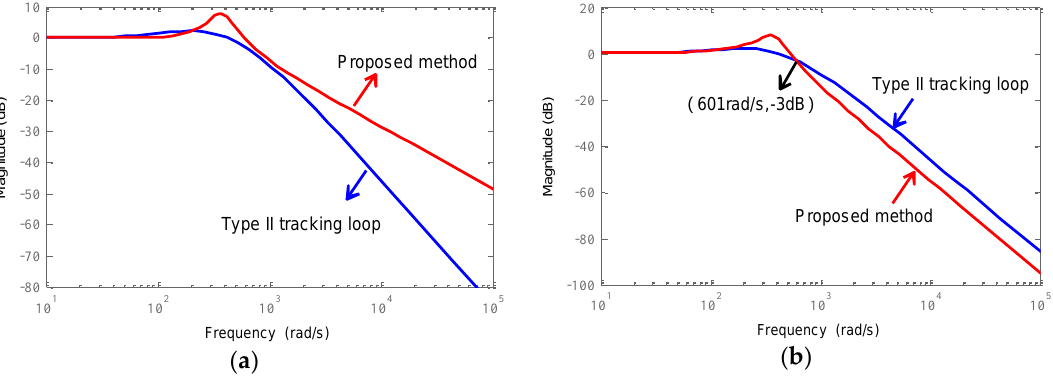
Figure 6. Amplitude-frequency characteristics of the two demodulation methods. ( a ) Angular position transfer function; ( b ) angular velocity transfer function.